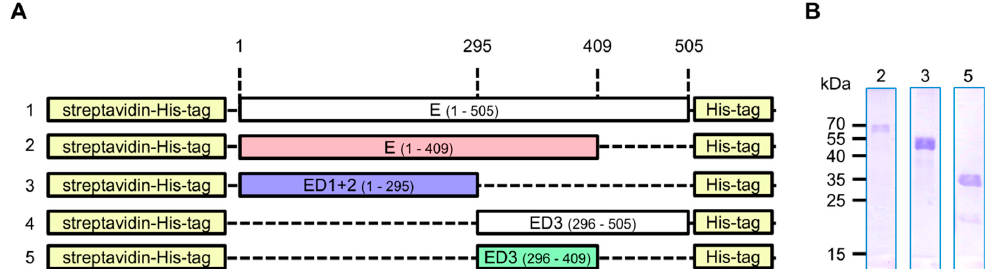
Figure 1. Construct design and protein production for rabbit immunization. ( A ) Schematic diagram of the designed constructs. The coding sequence of (1) the complete ZIKV E protein (aa 1–505), (2) the C-terminally truncated ZIKV E protein (aa 1–409), (3) the first two domains of ZIKV E protein (aa 1–295), (4) the Domain 3 of ZIKV E protein (aa 296–505), or (5) the C-terminally truncated Domain 3 of ZIKV E protein (aa 296–409) was cloned C-terminally to streptavidin-His-tag. Only constructs 2, 3, and 5 were successfully produced in E. coli ; ( B ) Coomassie staining of SDS-gel loaded with purified and refolded proteins produced using the constructs 2, 3, and 5 (from A ). The theoretical molecular weights of the purified proteins are: 60, 48, and 28 kDa,